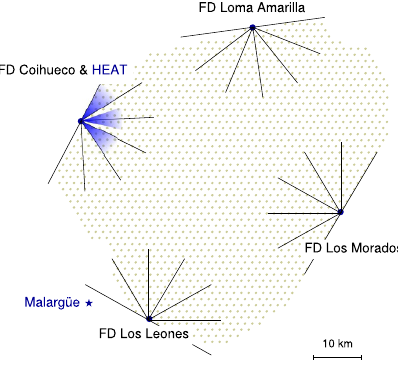
Figure 1. The layout of the Pierre Auger Observatory near the city of Malargüe. The SD array consisting of ∼ 1660 WCDs is overlooked by the 27 FD telescopes at four